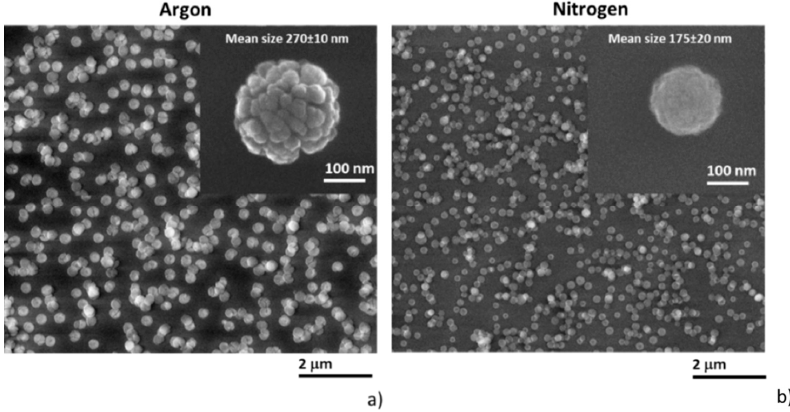
Figure 3. Scanning electron microscopy (SEM) images of C:H:N:O NPs deposited in ( a ) pure Ar or ( b ) N 2 . The presented mean sizes of produced NPs were evaluated from the diameters of 300 individual NPs.